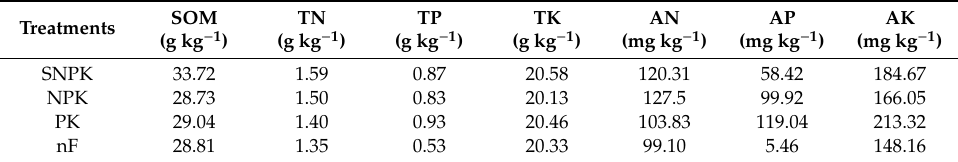
Table 1. Basic soil characteristics of the